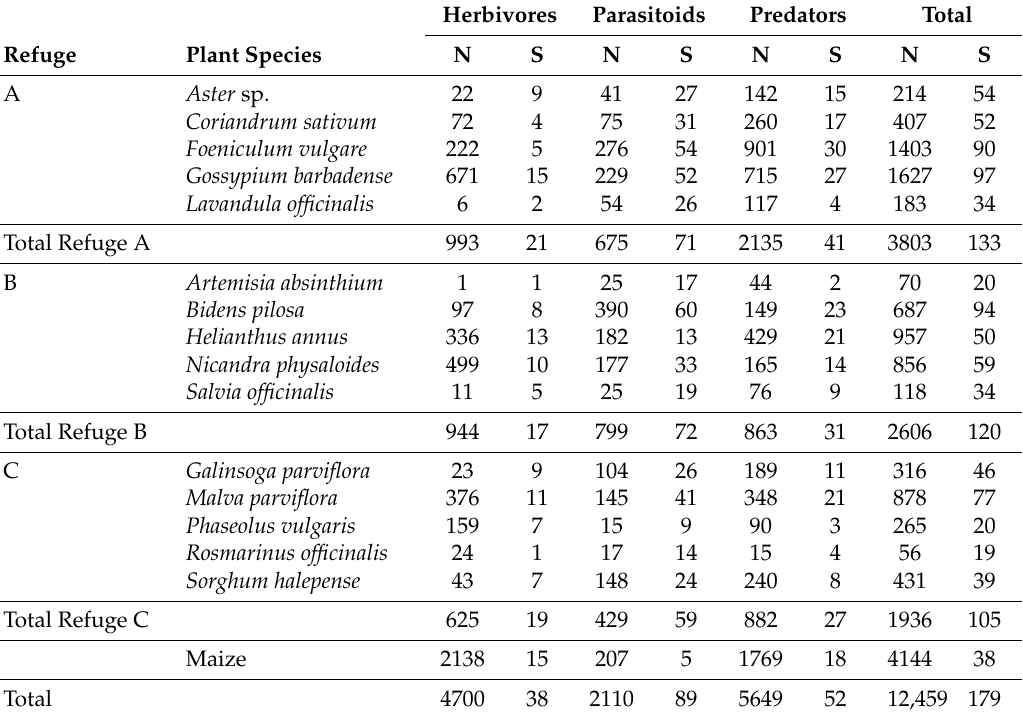
Table 2. Total number of individuals (N) and species (S) belonging to each functional group collected in each plant species in each refuge, including maize crops.